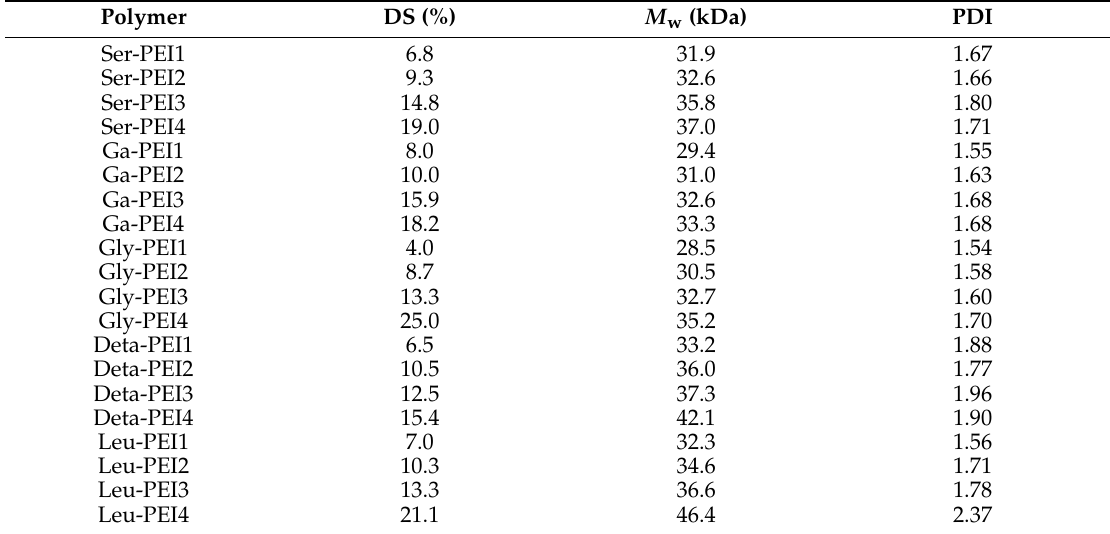
Table 1. Characterization of the polymers. DS was obtained from 1 H NMR and represents the DS of the entire amino groups in PEI. M w and polydispersity (PDI) were obtained from GPC.